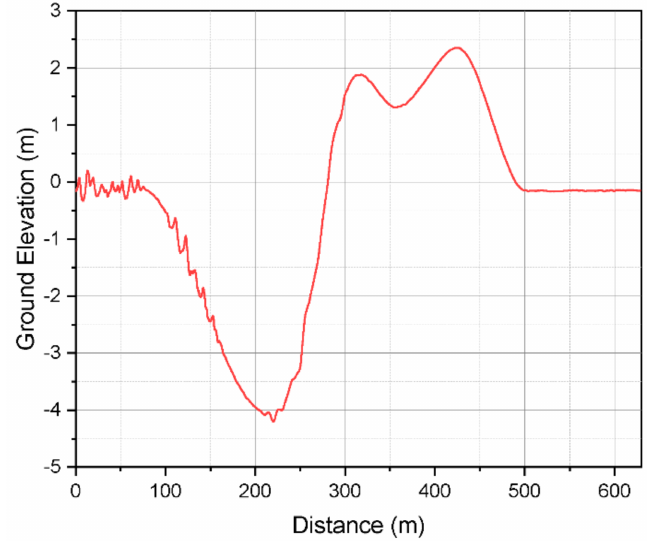
Figure 4. The ground elevation of the